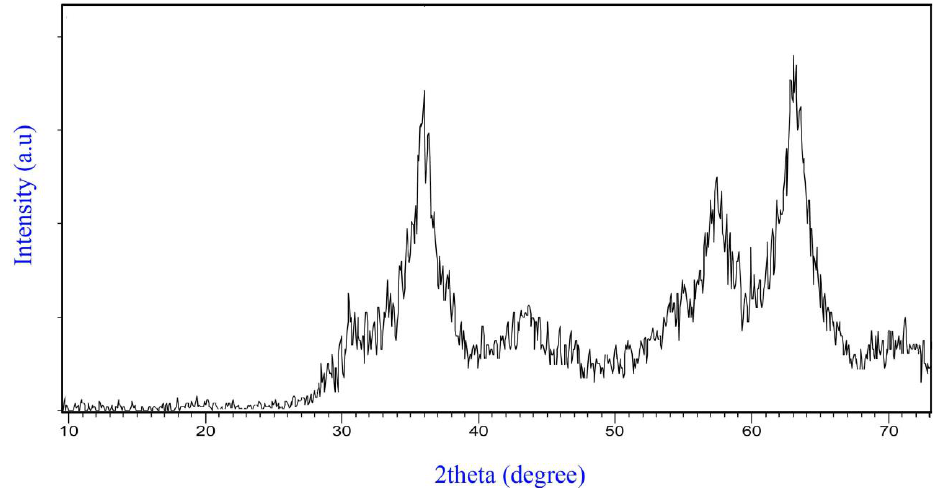
Fig. 2. XRD pattern of Fe